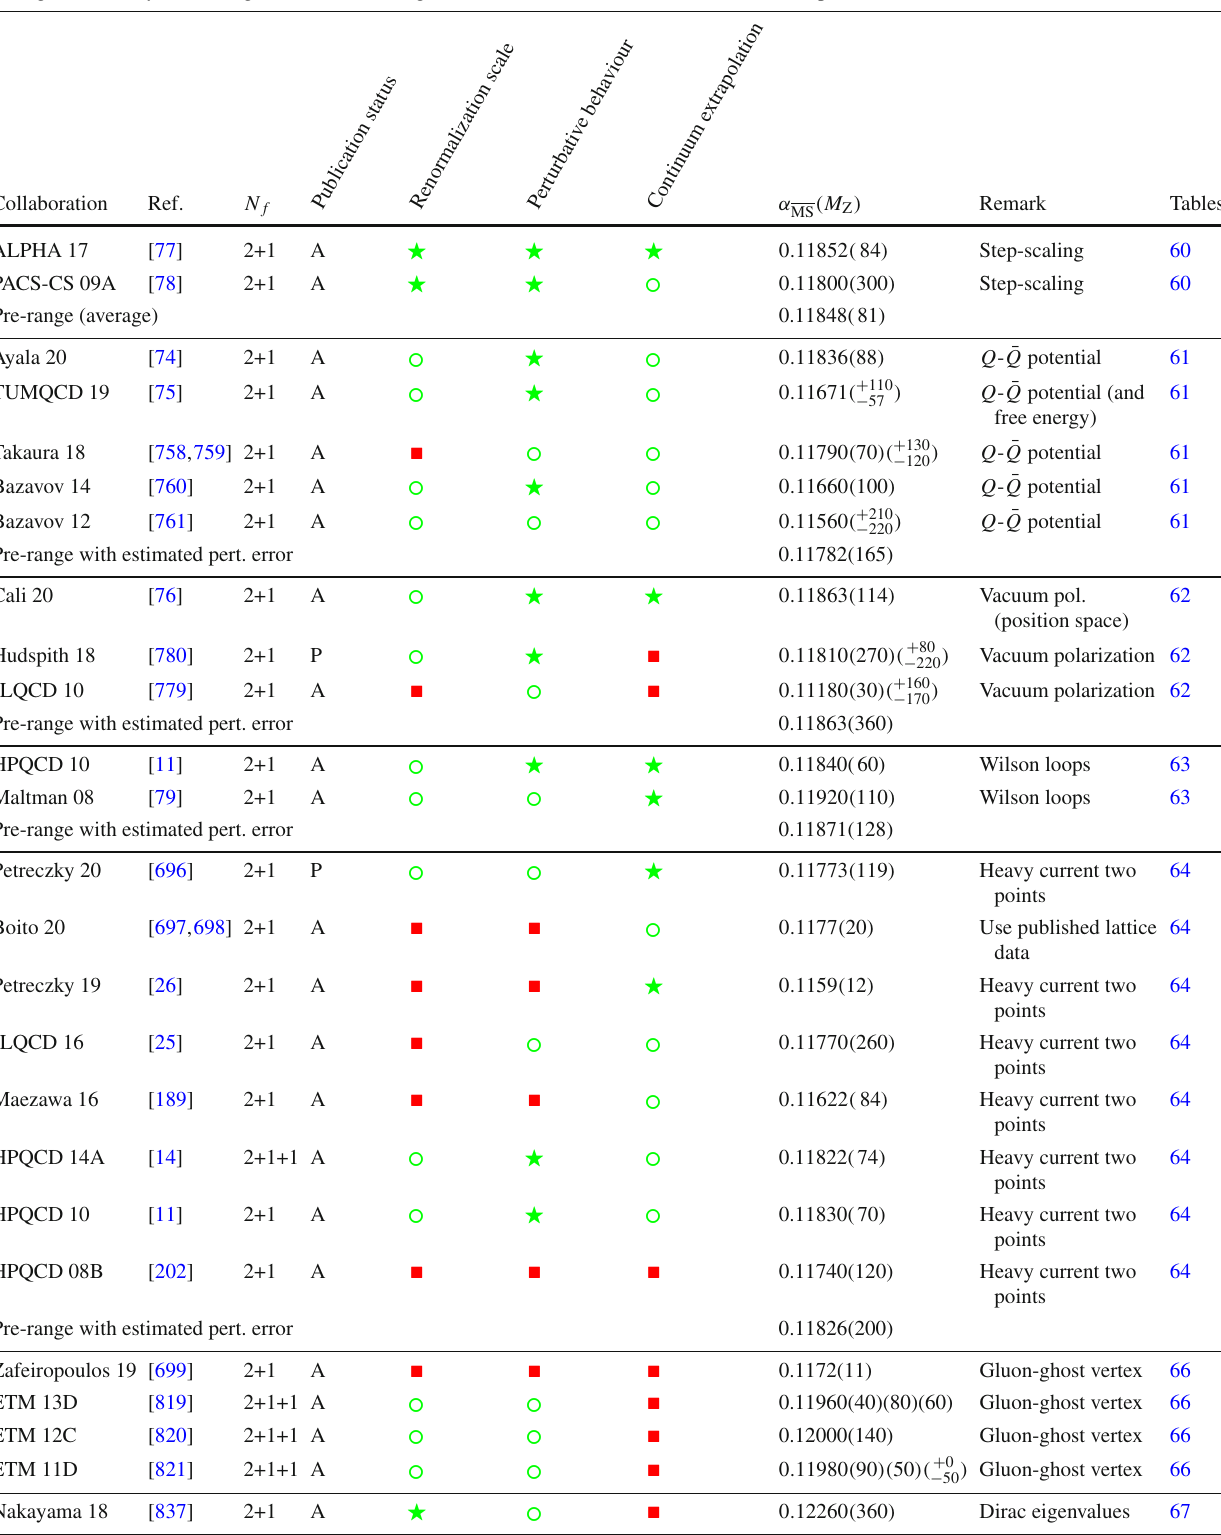
( M ) . Different methods are listed separately and they are combined to a pre-range when computations are available Table 68 Results for α Z MS without any (cid:2) . A weighted average of the pre-ranges gives 0 . 11843 ( 60 ) , using the smallest pre-range uncertainty gives 0 . 11843 ( 81 ) while the average uncertainty of the ranges used as an error gives 0 . 11843 ( 187 ) . Note that TUMQCD 19 supersedes Bazavov